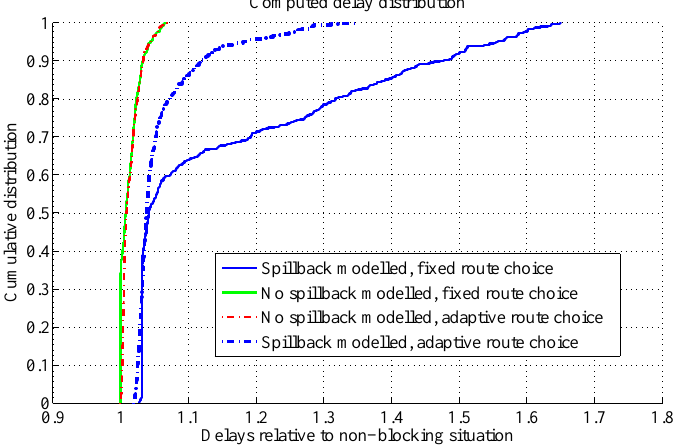
Figure 8. The distribution of the impact I when blocking a randomly chosen link From this analysis we conclude that the closure of a link appears of less importance if spillback is not simulated. For both the case with and without rerouting, the robustness is about the same. In none of the cases, the delay increases more than a few percent. If spillback is taken into account, there are more links causing a large performance drop. If paths are updated, the travel time increases by at most 36%, the point where the line “spillback, adapted routes” reaches 1. With fixed routes, the travel times can increase by more than 60% compared to a non-blocking scenario. So, robustness is overestimated if it is assessed by a non-spillback simulator and robustness can be increased by giving proper route